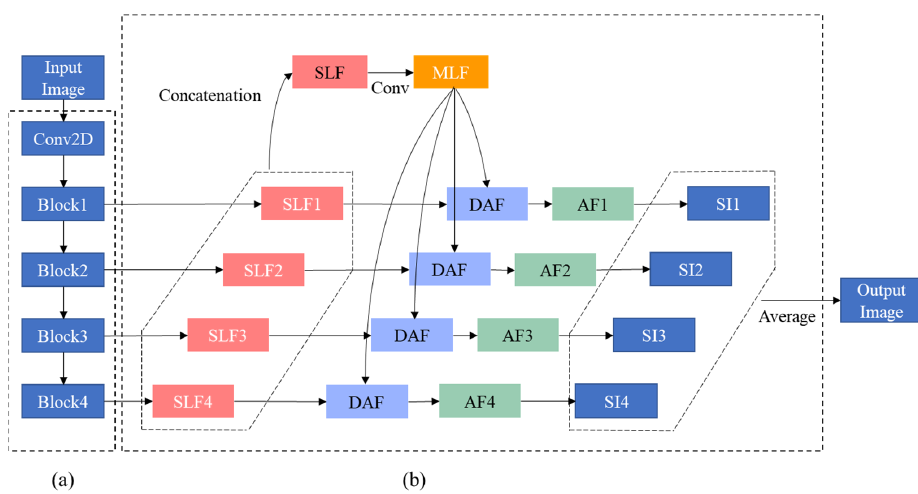
Figure 2. Block diagram of ( a ) encoder and ( b ) decoder parts of DAF-Net.